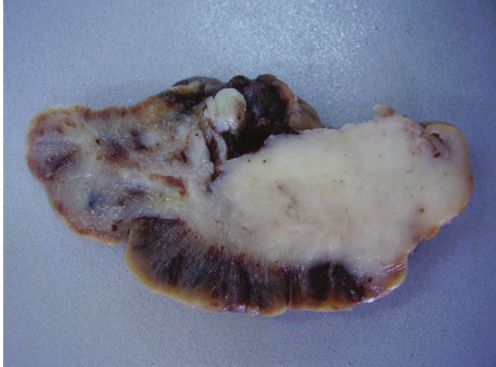
Figure 1: interlacing fascicles of elongated spindle cells with no glandular formations.